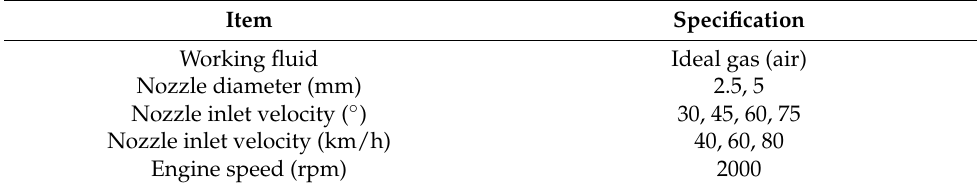
Figure 1. Model of intake manifold using a nozzle. Table 1. Simulation conditions of intake manifold using a nozzle. Item